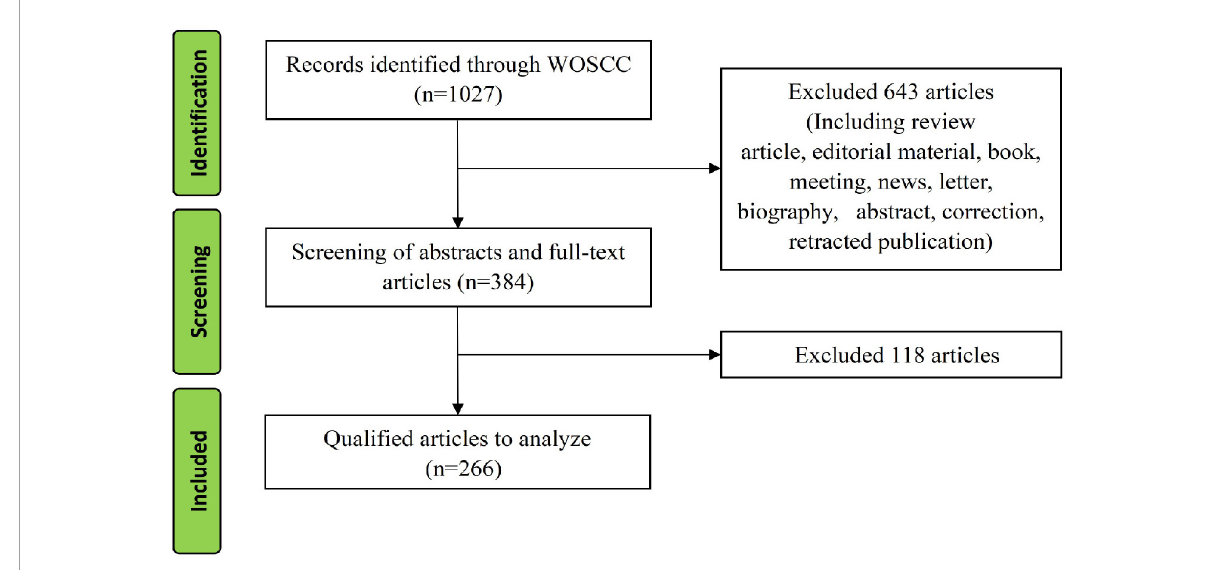
FIGURE1 Study flow diagram.